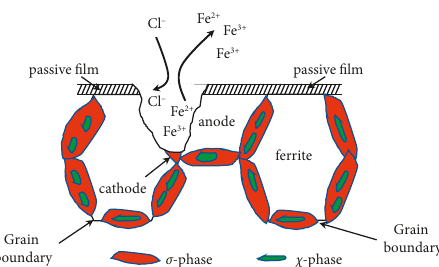
Figure 9: Schematic diagram of the pit formation at the interface between σ -phase/ χ -phase and ferrite matrix.